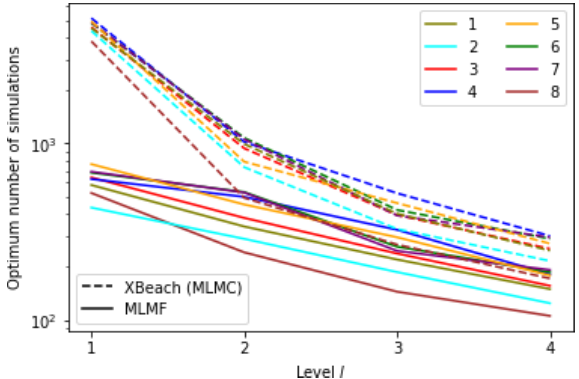
Figure 30. Optimum number of XBeach (HF) simulations required by MLMC divided by the optimum number required by MLMF for the Myrtle Beach test case. Here (cid:15) = 3 × 10 − 3 in Eqs. (14) and (B7) for MLMF and MLMC respectively.